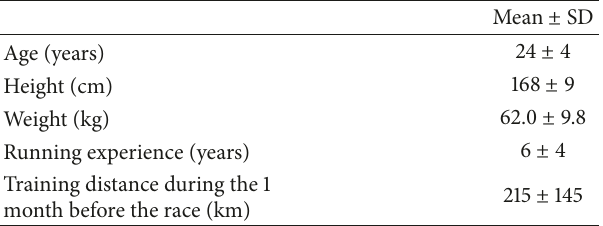
Table 1: Physical characteristics and training status of the